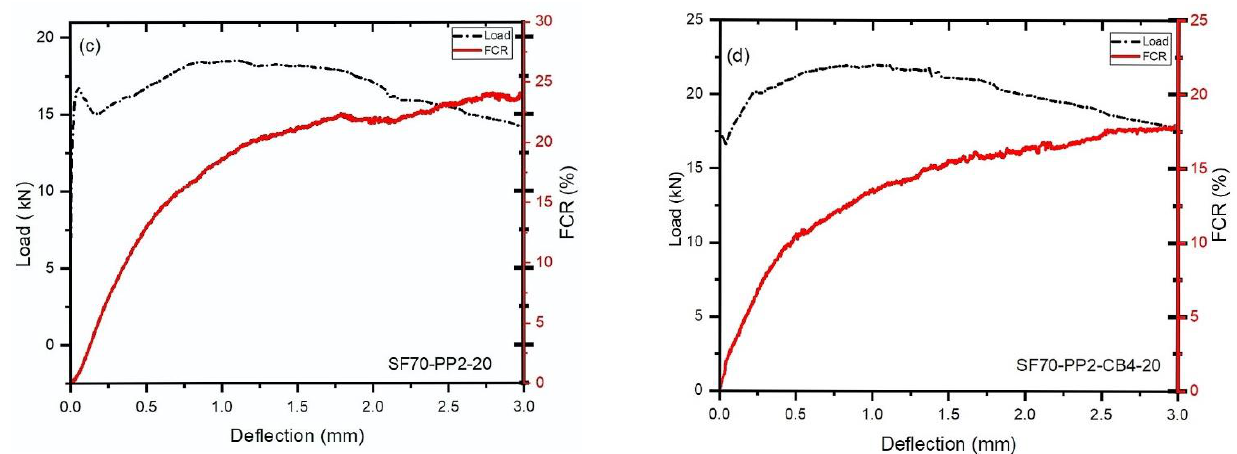
Figure 5. Load-deflection-FCR curves of 15–20 mm coarse aggregates ( a ) SF70-20 ( b ) SF70-CB4-20 ( c ) SF70-PP2-20 ( d ) SF70-PP2-CB4-20.